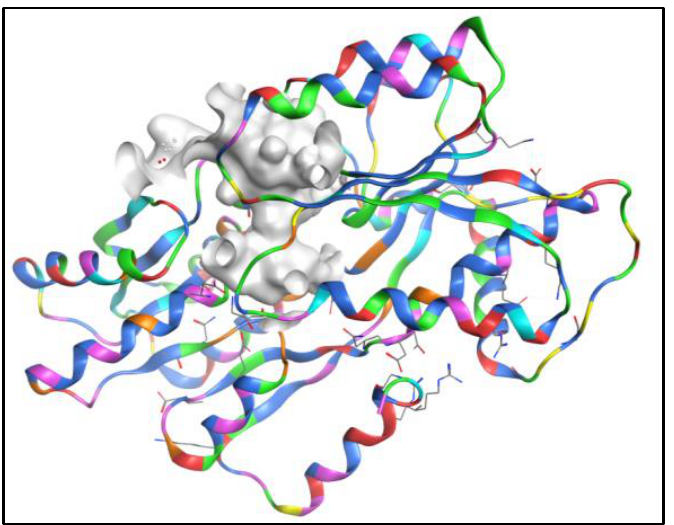
Figure 4. The docking site (grey/white colour) of the LuxP protein in V. carchariae . The binding affinities range between − 11.0 and 0 (kcal/mol). A score for each AQ-